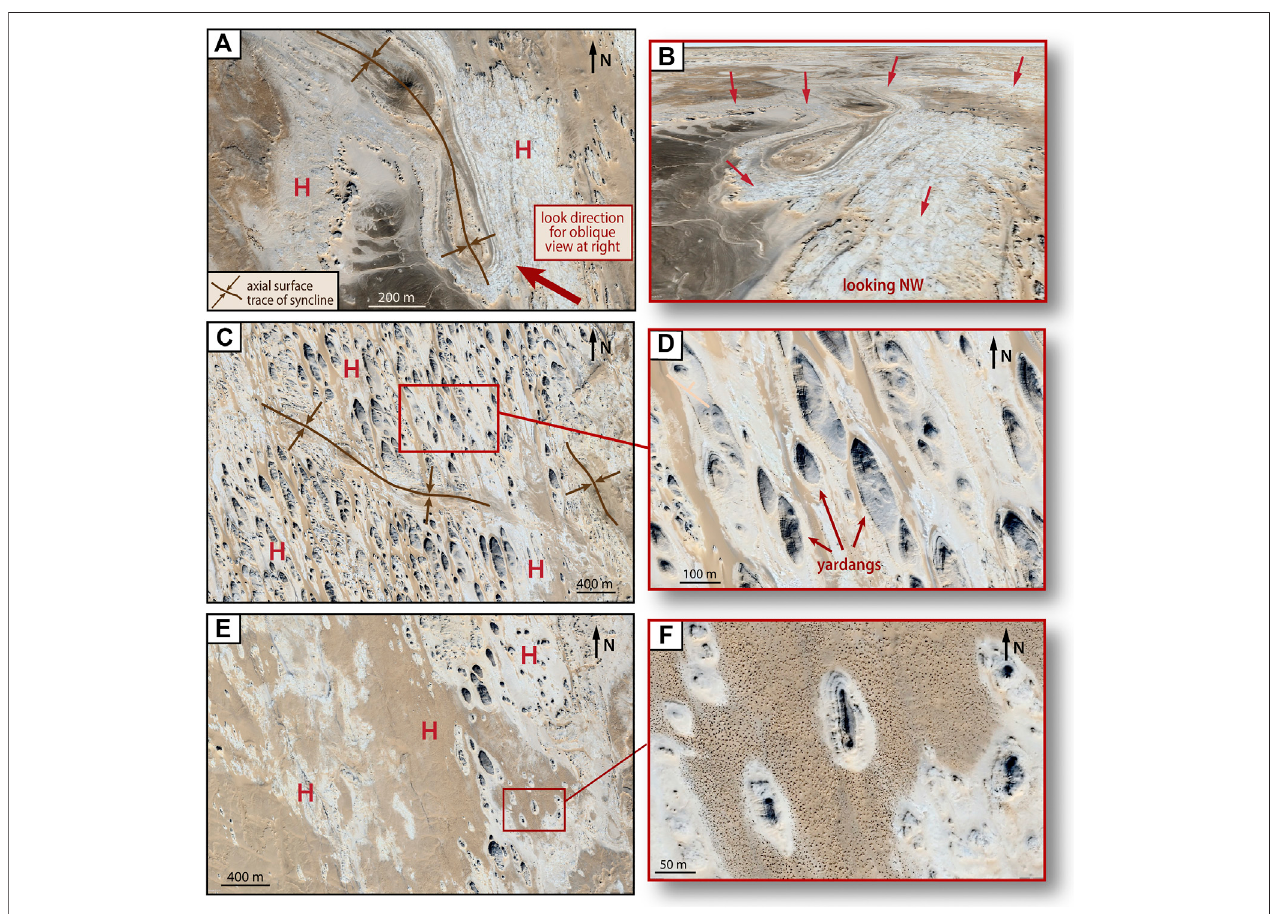
FIGURE5| Mappingmethods.Ourmappingalsomakesuseofthedistinctivepatternsofquasi-horizontallimestonelayersininter-synclineareas,asestablishedin our previous mapping area (Tewksbury et al., 2017a). Red H indicates horizontal bedding. (A) Non-siliceous white limestone with low-relief, wind-scoured surfaces, dendritic outcrop patterns, and scattered erosional remnants of eroded younger layers. (B) Oblique view looking NW across syncline shown with red arrow in 5A; red arrows showextensiveoutcrop areaofasingle,thinwhitelimestonelayerwherebeddingisquasi-horizontal. (C) Yardangs(stream-lined, wind-erodedridges) with quasi-horizontal bedding surrounded by scoured white limestone. (D) Zoomed-in view of 5C, showing horizontal bedding in yardangs. (E, F) Thin, resistant siliceous limestonelayersformaeriallyextensivepalebrownsurfaceswithconcretions(darkbrownspecklesin5F)anderosionalremnantsofyoungerlayersoflimestone.Satellite imagery source: Google Earth. Coordinates for Google Earth images: A) 26.287473, 30.968942; B) 26.282612, 30.970593; C) 26.446217, 30.929685; D) 26.450399, 30.931964; E) 26.297099, 30.925204; F) 26.292921, 30.934480.